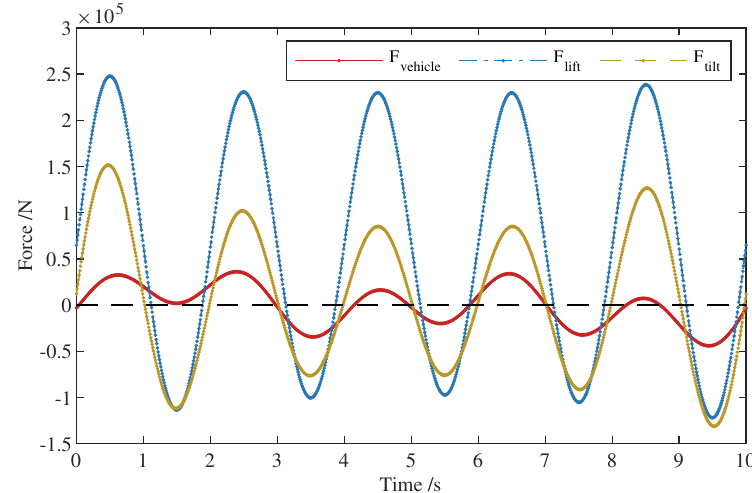
Figure 13. Driving forces of vehicle body, lift cylinder, and tilt